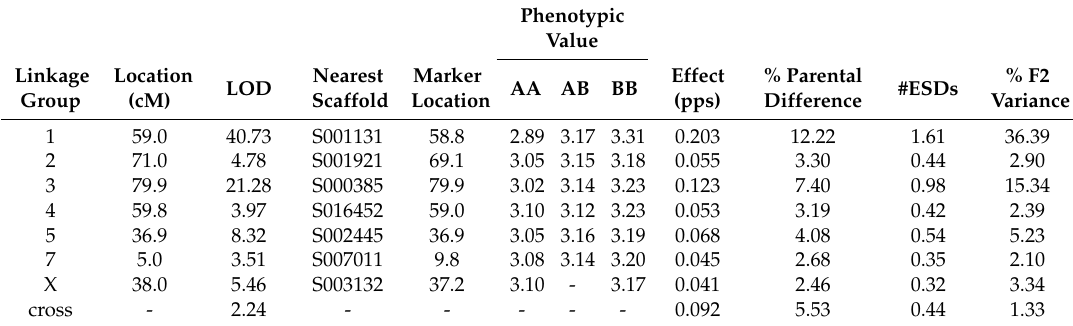
Table 3. QTL results from the combined map. The QTL were mapped using the consensus map for the 230 F 2 individuals. LOD—log-of-odds. The A and B alleles denote the L. cerasina and L. eukolea alleles, respectively. All of the QTL effects are significantly different from zero. ESD—environmental standard